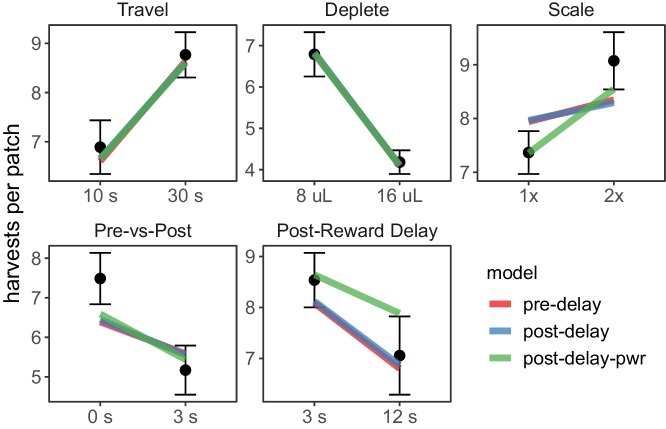
Predictions of the best fit biased time perception models.Predictions of the best fit models of overestimation of pre-reward delays (pre-delay), linear underestimation of post-reward delays (post-delay), and nonlinear underestimation of post-reward delays (post-delay-nonlinear). Points and errorbars are the mean ± standard deviation of rat behavior, colored lines represent the mean model predicted number of harvests across all rats.